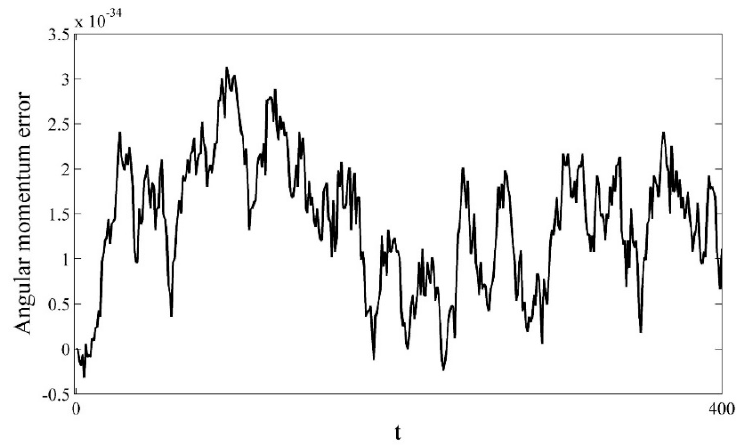
Figure 9. Six balls: Angular momentum error of LGG with time step η = 1 and m = 2.